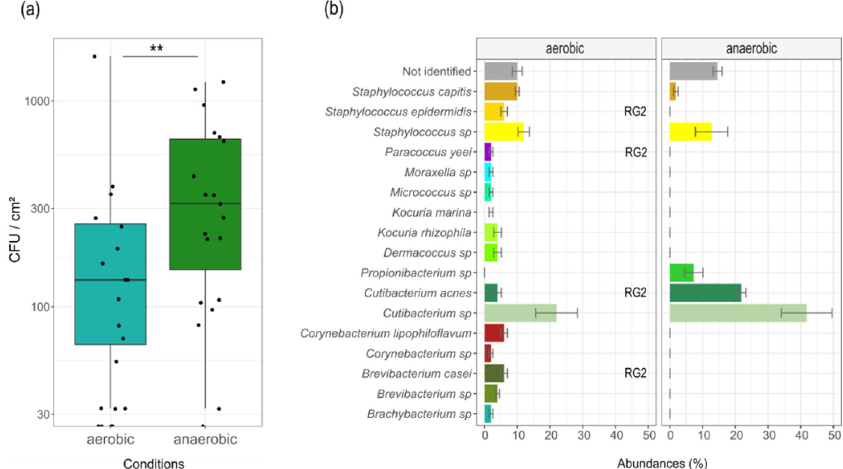
Figure 2. Microbial load and relative taxonomic abundances of bacteria isolated from ten uncleaned microscope oculars under two cultivation conditions: ( a ) Box-whisker plot showing the microbial counts (CFU cm − 2 ) under two cultivation conditions and from two cultivation media ( n = 10 oculars, each) before cleaning. Displayed are median, 25% and 75% quartiles, and outliers. Whiskers represent the lowest and highest microbial counts within the 1.5-fold of the interquartile range (IQR) (the 25% and 75% quartile). Asterisks mark a statistically significant difference between cleaned and uncleaned oculars (** p = 0.009), based on Wilcoxon Signed Rank Test; ( b ) Barplot of identified bacterial taxa isolated from the oculars before cleaning. Bars show the relative abundance for aerobic cultivation (n = 50 isolates) and anaerobic cultivation ( n = 55 isolates). ‘Not identified’ indicates a MALDI identification score <1.7. ‘RG2’ indicates a risk group 2 classification according to German TRBA. Data are expressed as median ± standard deviation.